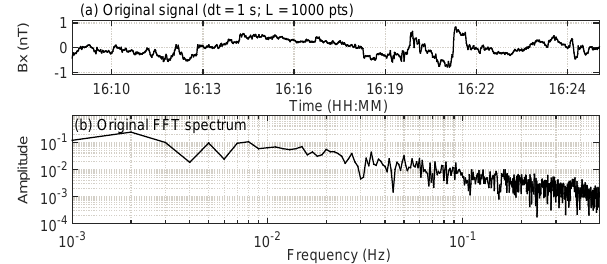
Figure 12. A Venus Express (VEX) magnetic field signal. Panel (a) shows the B x component of the magnetic field as a function of time and panel (b) shows its FFT amplitude